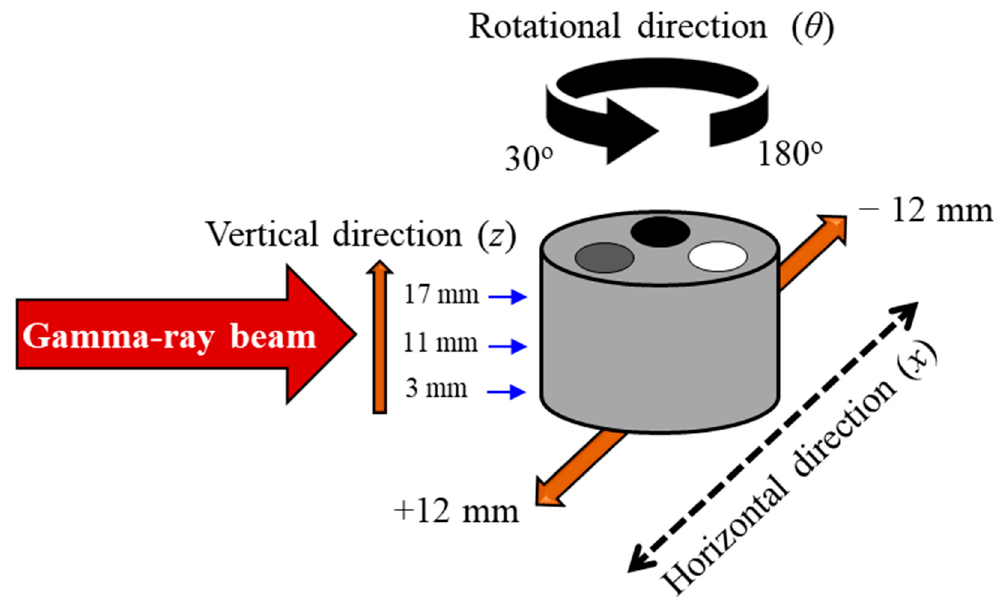
Figure 3. Data acquisition geometry of the CT target in three dimensions. In the horizontal direction ( x ), the CT target position was scanned from − 12 mm to +12 mm in steps of 4 mm within the movement range. In the rotational direction ( θ ), the CT target was rotated around the axis of rotation, with angle steps of 30° in the range from 30° to 180°. The three layers in the vertical direction ( z ) were scanned at 3, 11, and 17 mm from the CT target bottom.